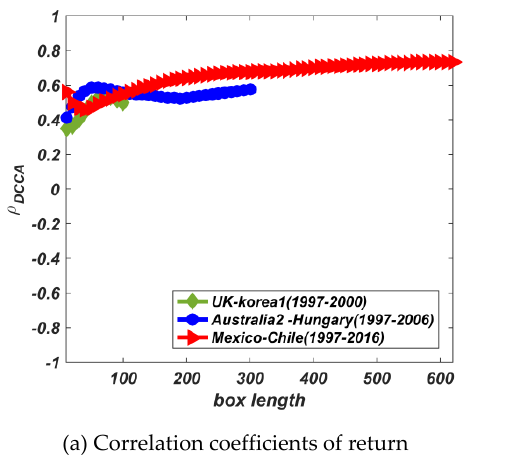
Figure 3. Examples of pairs with strong correlation as a result of detrended cross-correlation analysis (DCCA): we construct a network by linking two stock markets where the average 𝜌 𝐷𝐶𝐶𝐴 is above 0.7 (intermediate value of strong correlation and very strong correlation).